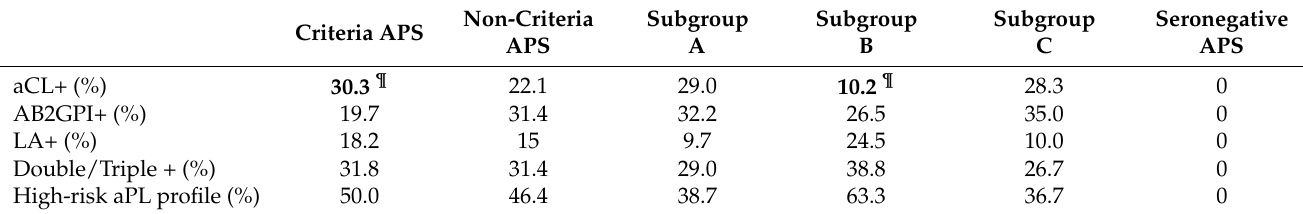
Table 4. Main serological groups.